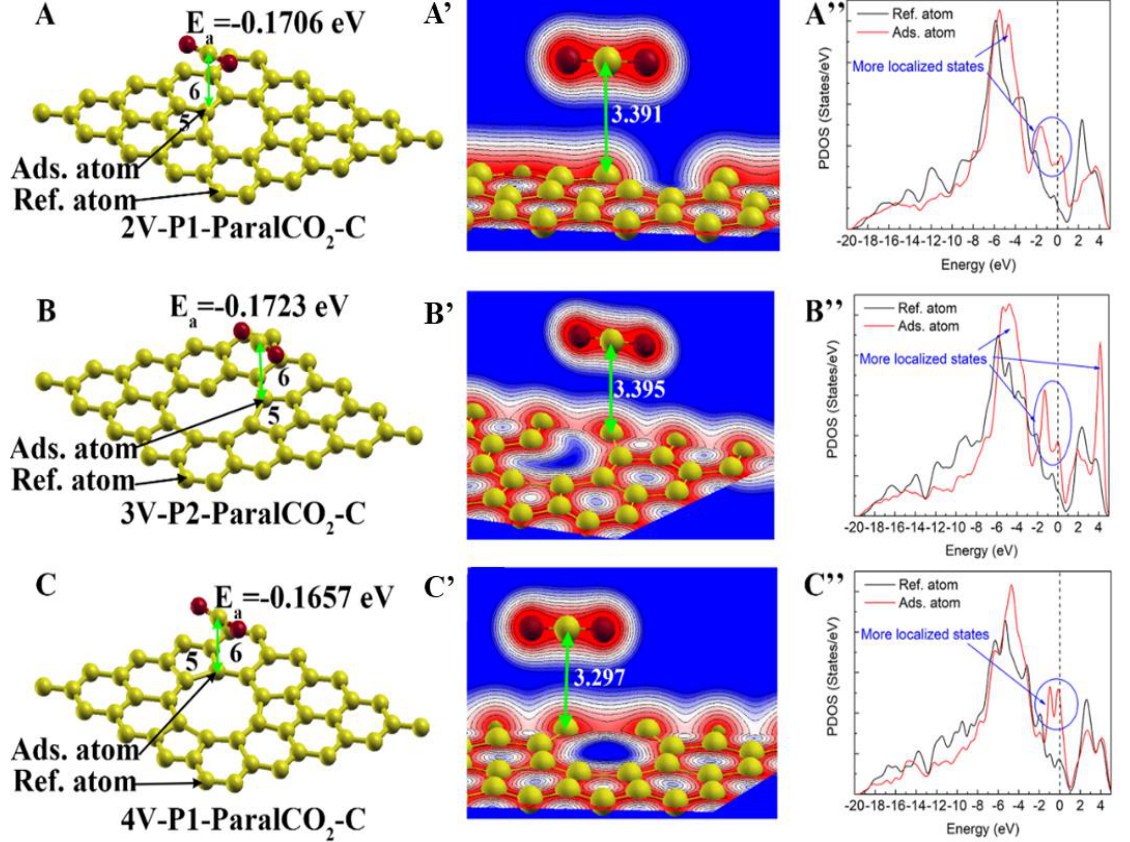
Figure 8. CO 2 physisorption on carbon atoms shared by a 5-membered ring, a 6-membered ring and a vacancy: ( A , A’ , A’’ ), ( B , B’ , B’’ ) and ( C , C’ , C’’ ) represent the atomic structure/charge distribution/PDOS of adsorption configuration on divacancy (2V), trivacancy (3V) and tetravacancy (4V), respectively. The Fermi level is represented by the dashed vertical line.